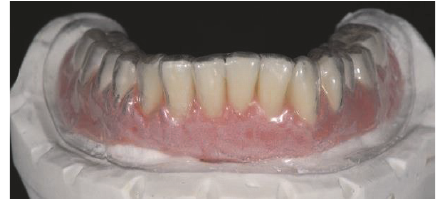
Figure 4: Preoperative situation. A 52-year female patient in good general health had a complete removable denture in the maxilla and a severe acute periodontitis in the mandible, with several teeth with reducedbonesupportandthereforehighmobility. Thepatientasked for a full arch implant supported rehabilitation of the mandible, possibly involving an immediate loading protocol.